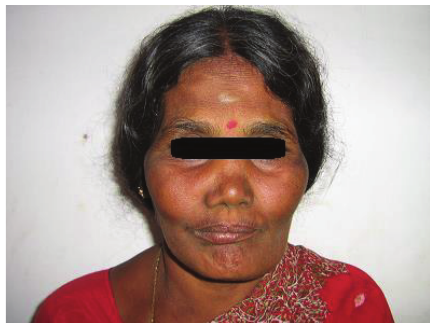
Figure 2: Facial view showing bilateral swelling of maxilla and zygoma.